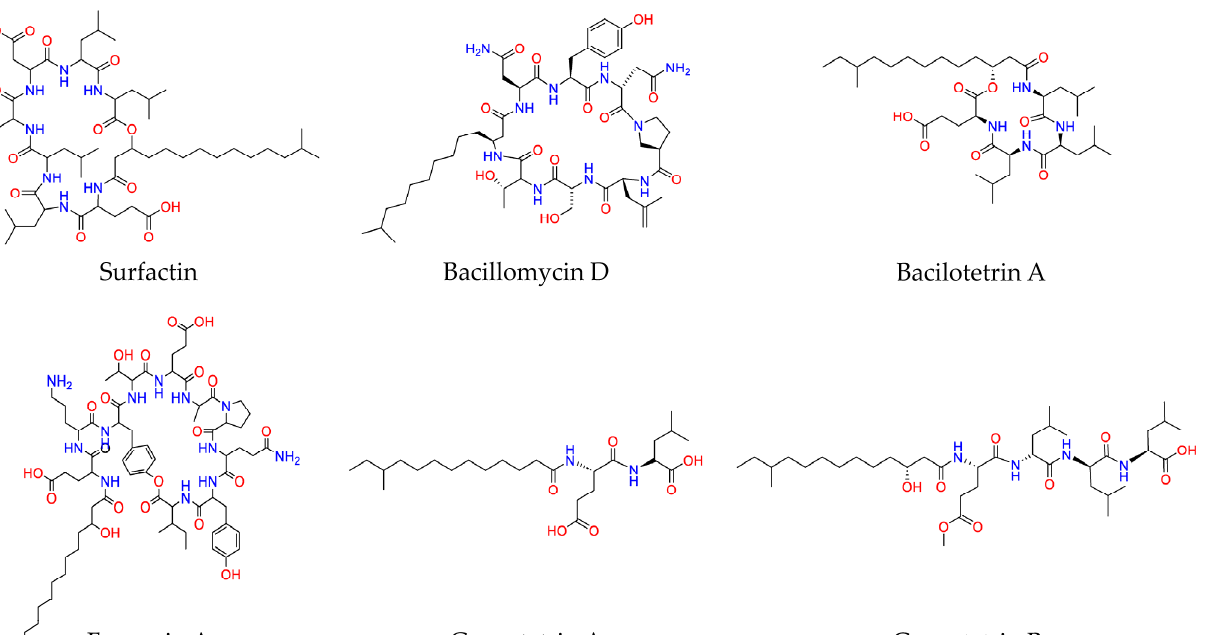
Figure 1. Chemical structures of representative lipopeptides (LPs) produced by the olive tree endo- phytic Bacillus sp. PTA13 isolate [6]. The structures were designed using the software ChemDraw Professional v.22.2.0 [9] .